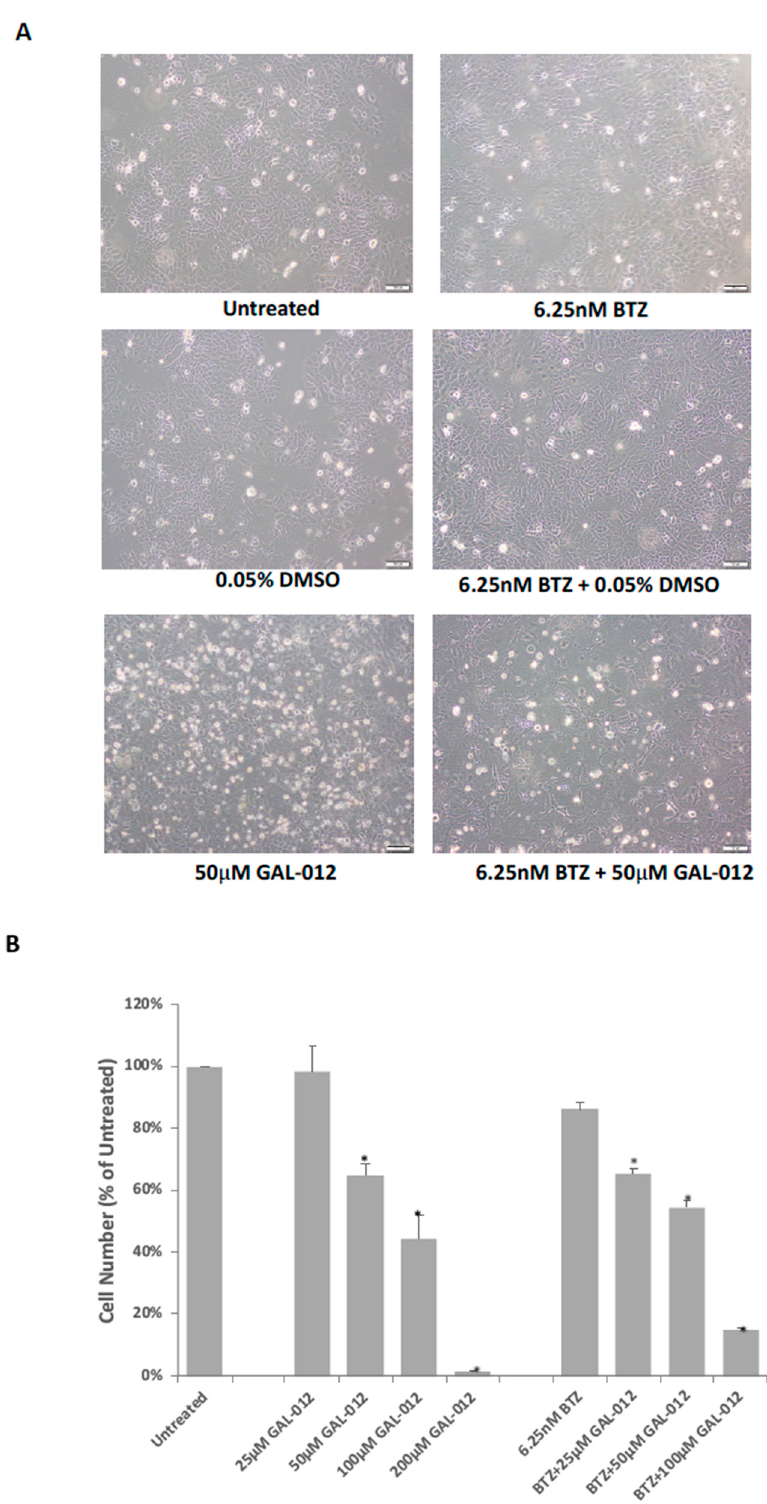
Figure 7. GAL-012 increased sensitivity to Bortezomib (BTZ) in HepG2 cells. ( A ) Photomicrographs showing the growth of HepG2 cells treated with varying concentrations of GAL-012 in the presence or absence of 6.25 nM BTZ for 96 h. ( B ) Quantification of cell growth of HepG2 treated with varying concentrations of GAL-012 in the presence or absence of 6.25 nM BTZ for 96 h. * p < 0.05.